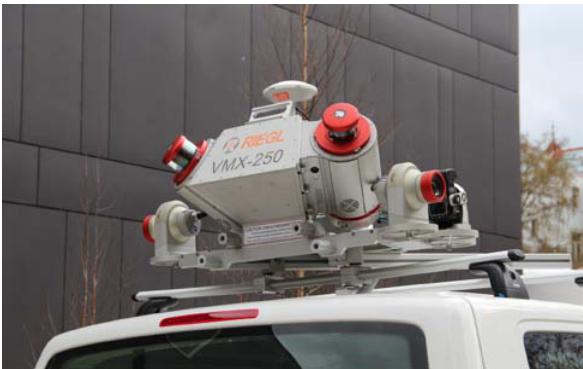
Figure 2. Riegl VMX-250 mobile mapping system